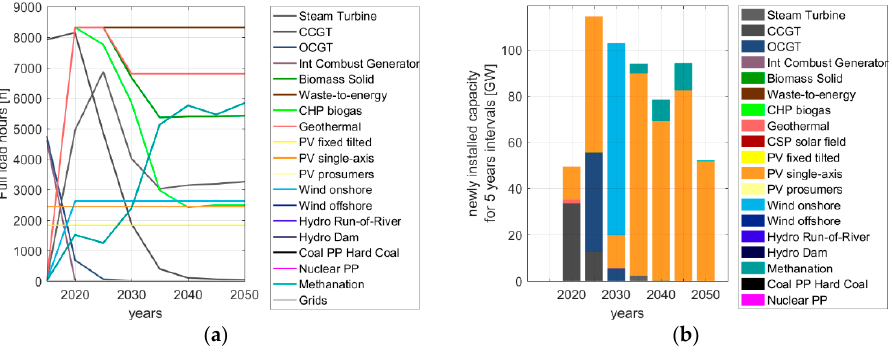
Figure 8. FLH variation of the different power plants used in model ( a ) and additional capacities of different power plants required from 2015 to 2050 ( b ).